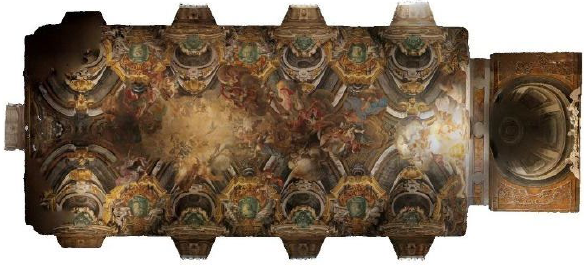
Figure 8. Orthogonal projection of the geometry of the vault and the paintings that decorate